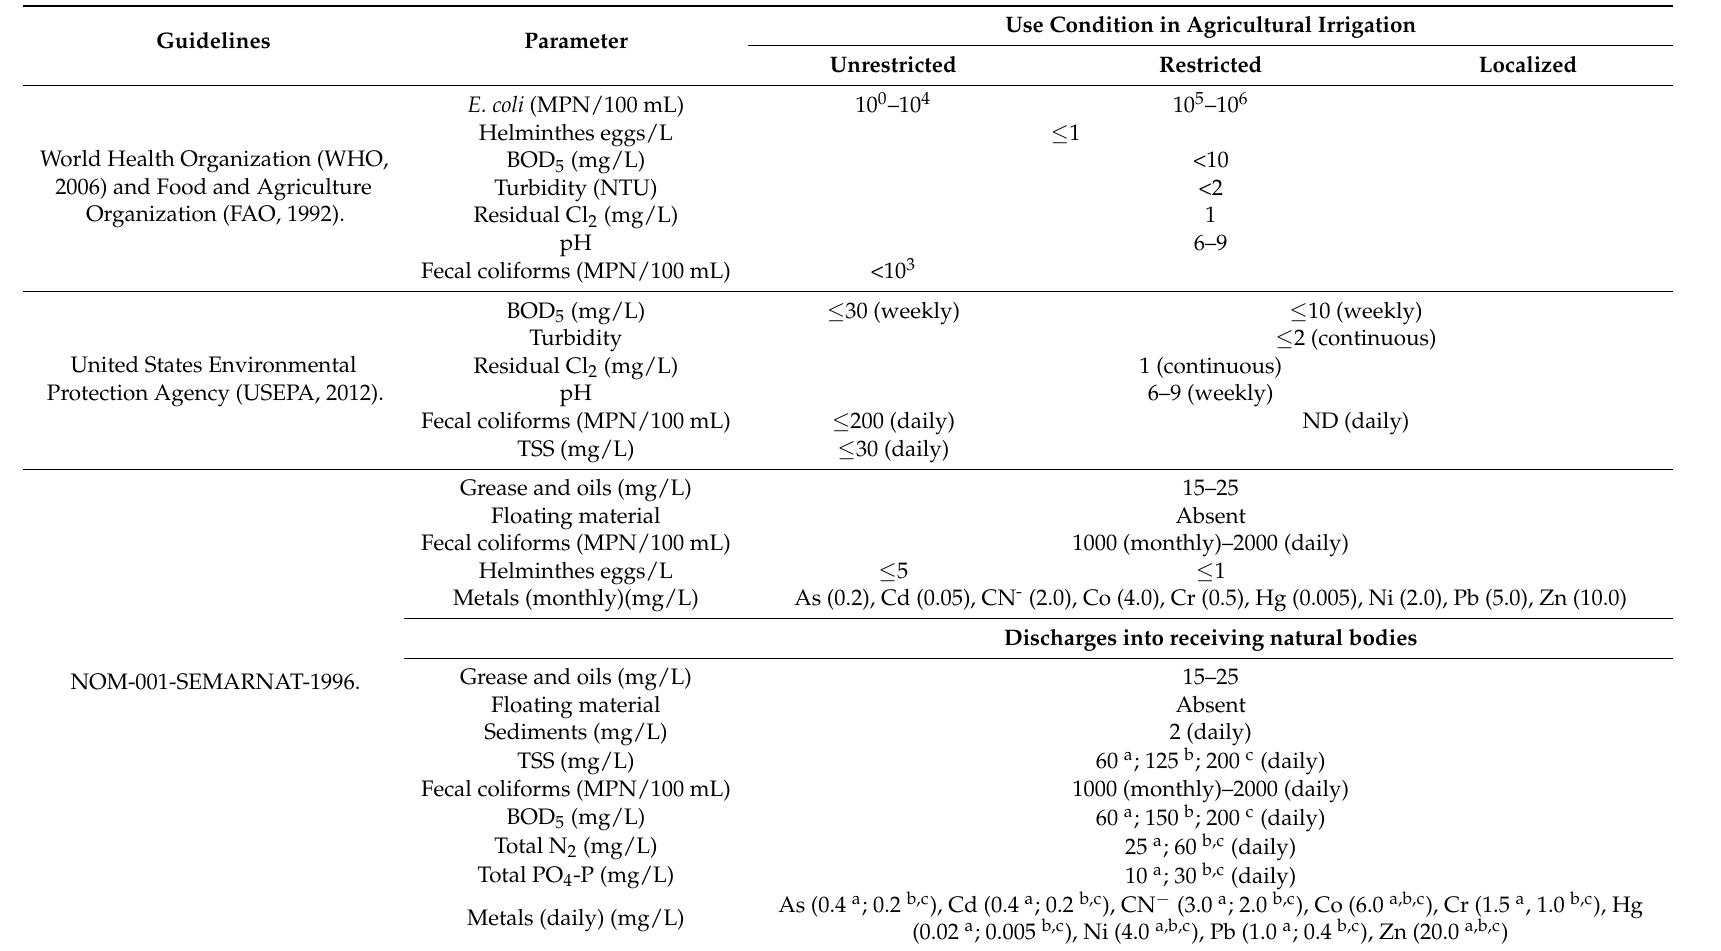
Table 2. International and national regulations for the use of RW in agriculture and aquifer